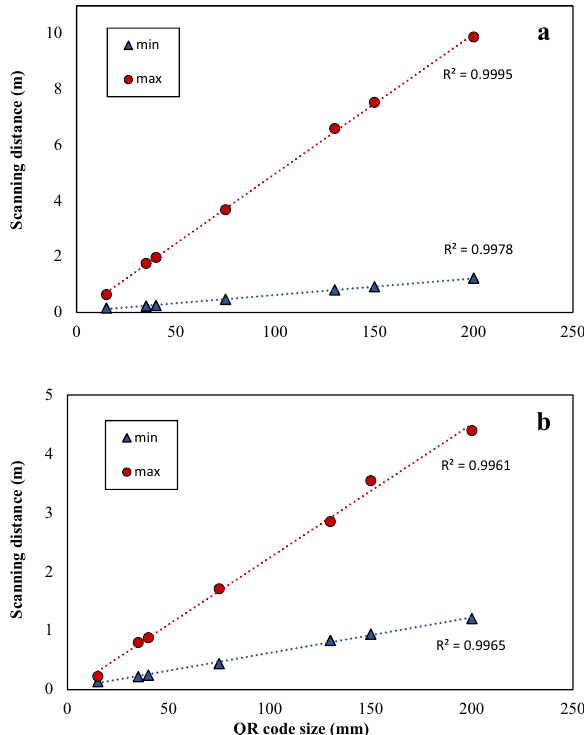
Figure 2. Simple linear regression between minimum and maximum scanning distance (m) and QR code size (mm). Version 3 QR code (V3) with 29 × 29 modules ( a ), Version 11 QR code (V11) with 61 × 61 modules ( b ).